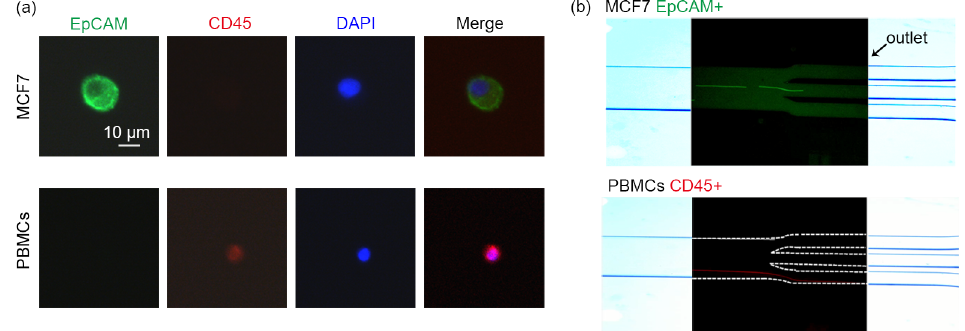
Figure 3. Characterization of cancer cells and PBMCs by immunofluorescence. ( a ) Expression of epithelial biomarkers EpCAM (green) and pan-leukocyte marker CD45 (red) in MCF7 cells and PBMCs. The cell nucleus was stained with DAPI dye (blue). Scale bar = 10 μ m. ( b ) Images of fluorescently labeled cancer cells (green) as well as PBMCs (red) flowing through different outlets of the microfluidic chip.